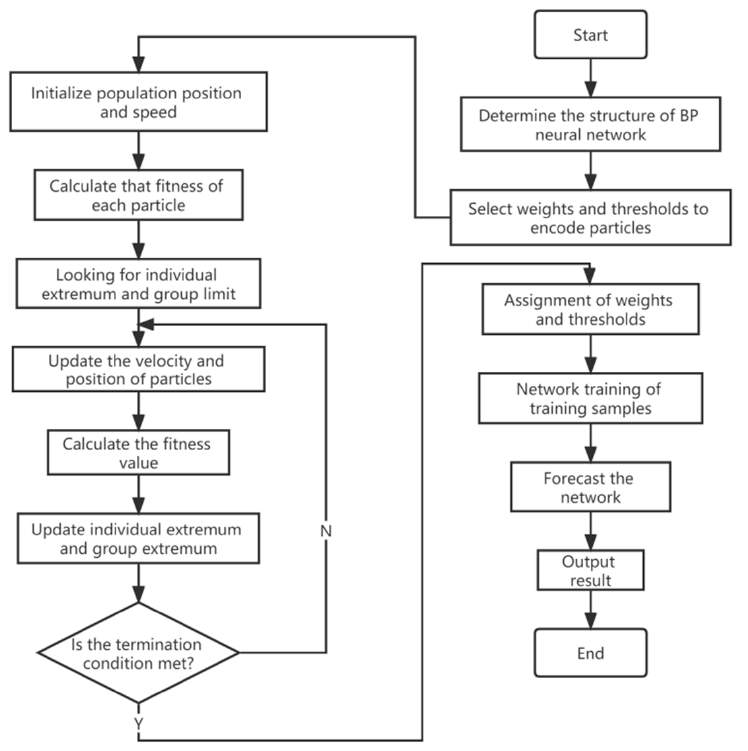
Figure 10. Flowchart of the PSO-BP ANN algorithm.